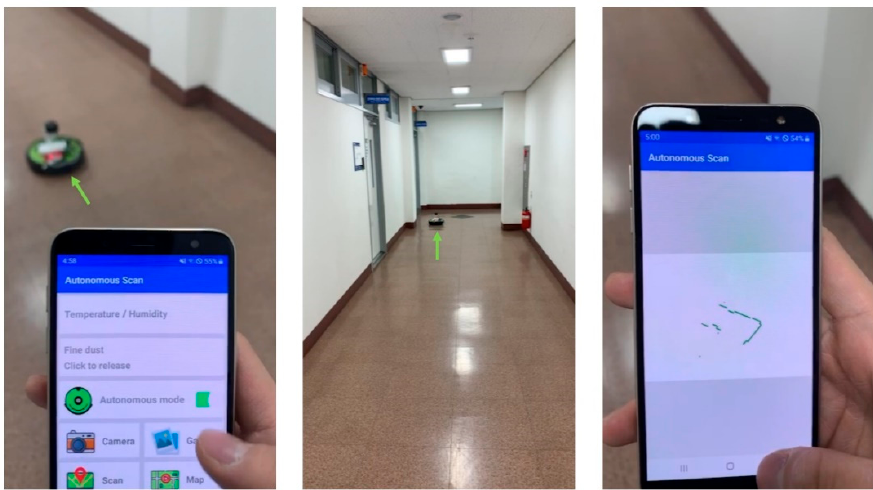
Figure 13. Autonomous mode operation example. Activation of autonomous mode ( left ), autonomous scanning operation of system ( middle ), and scanned result in autonomous mode ( right ).